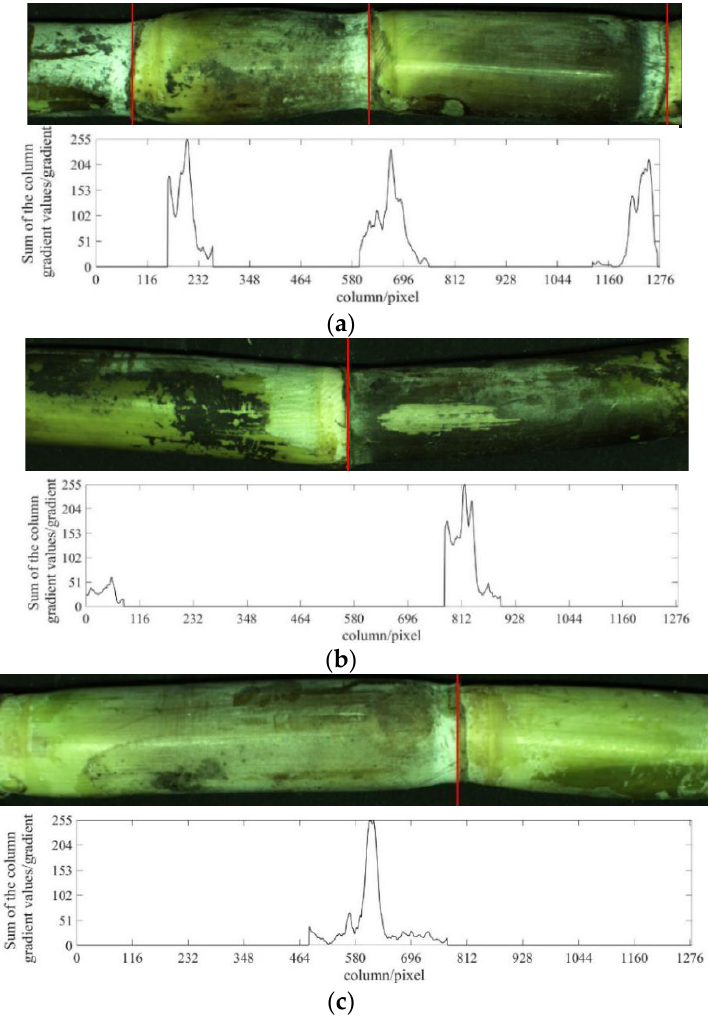
Figure 12. The output results of the algorithm combining YOLOv3 and traditional methods of computer vision: ( a ) three stem nodes, ( b ) repeated recognition, and ( c ) non-stem node recognition into stem